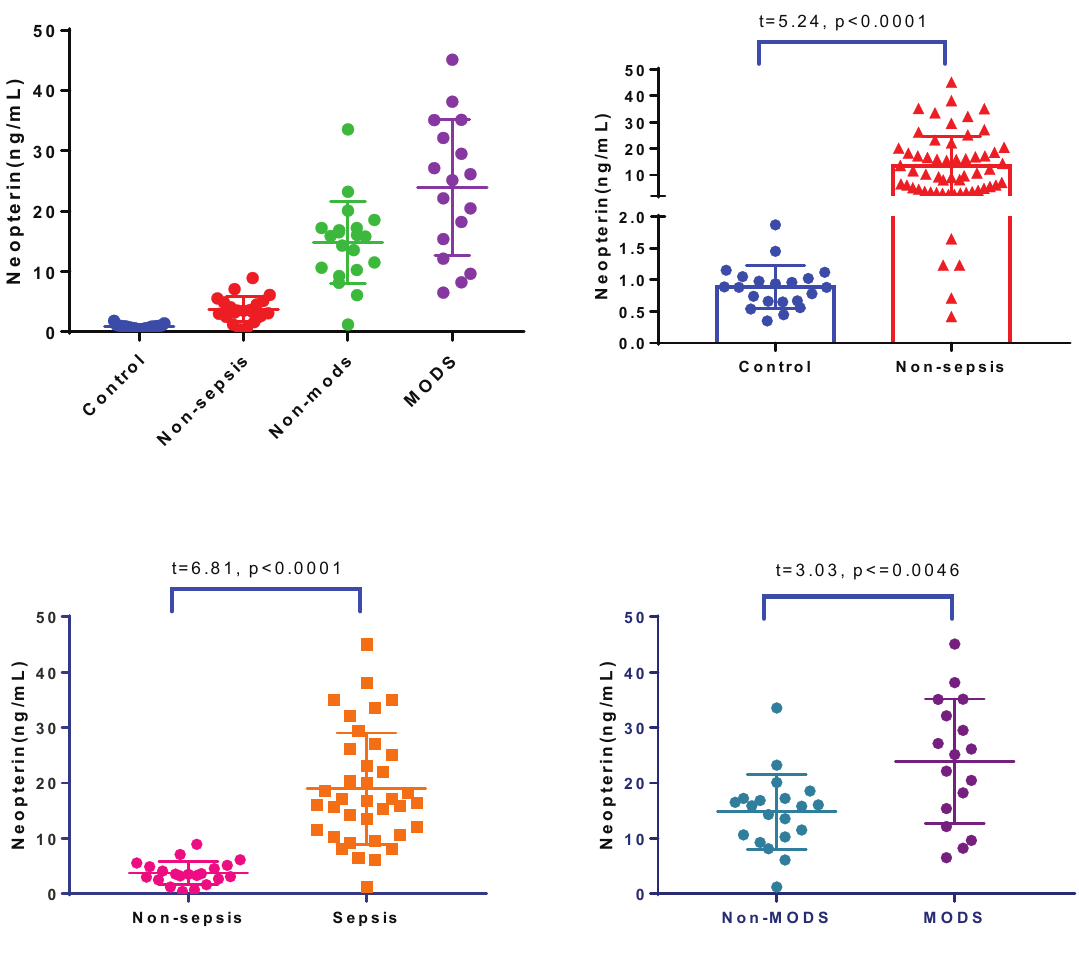
Figure 1: Derum neopterin concentration at the time of admission for different groups.